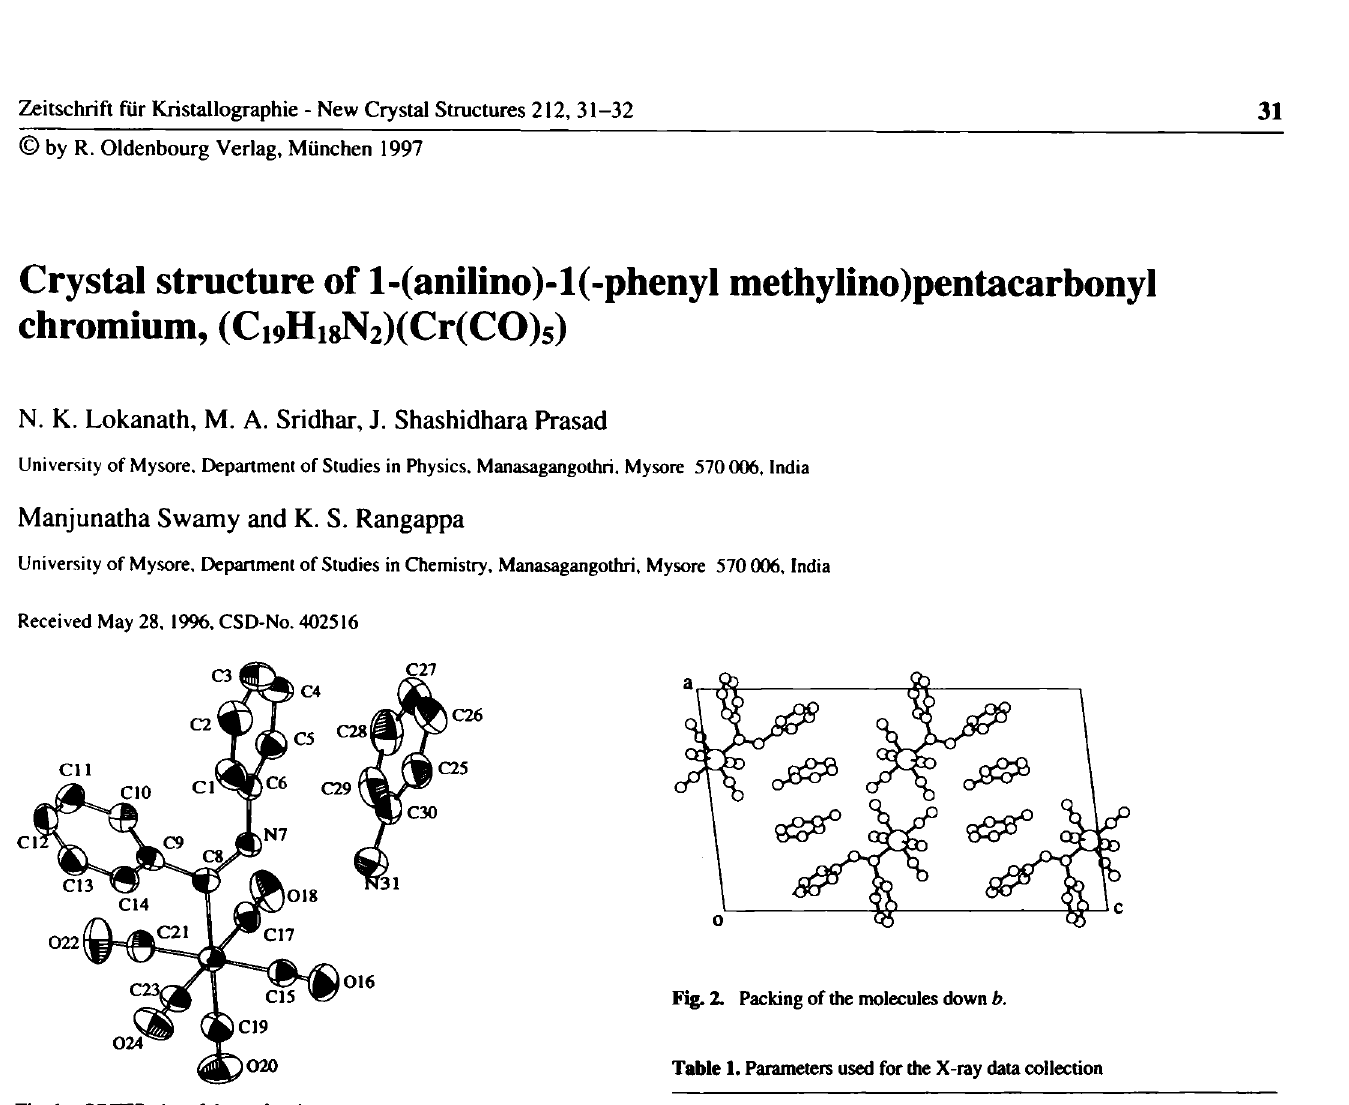
Fig. 1. ORTEP plot of the molecules.